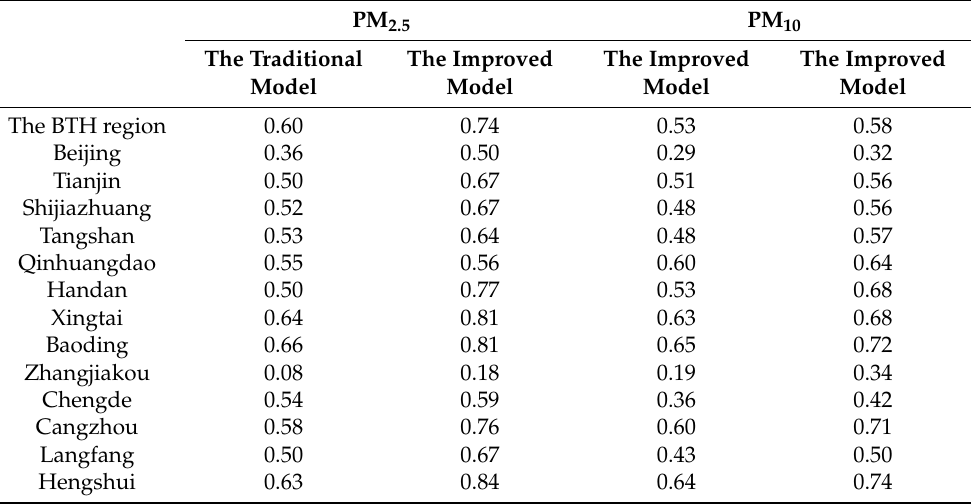
The Traditional Model